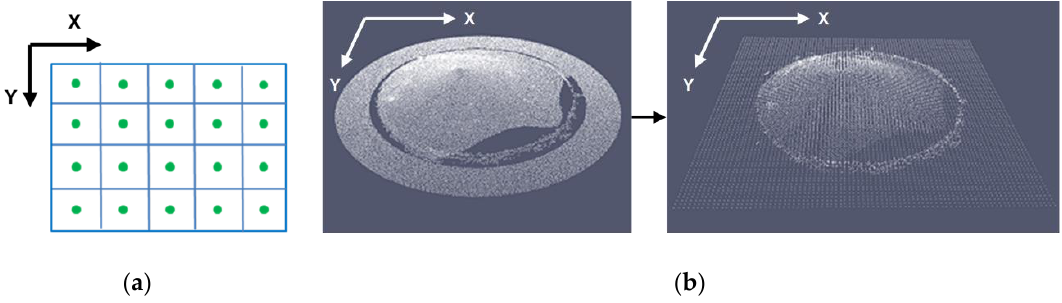
Figure 16. Procedure to generate a rectangular grid from a point cloud: ( a ) the rectangular grid configuration; ( b ) example of rectangular grid generation from the stretched point cloud corresponding to Patient 002.